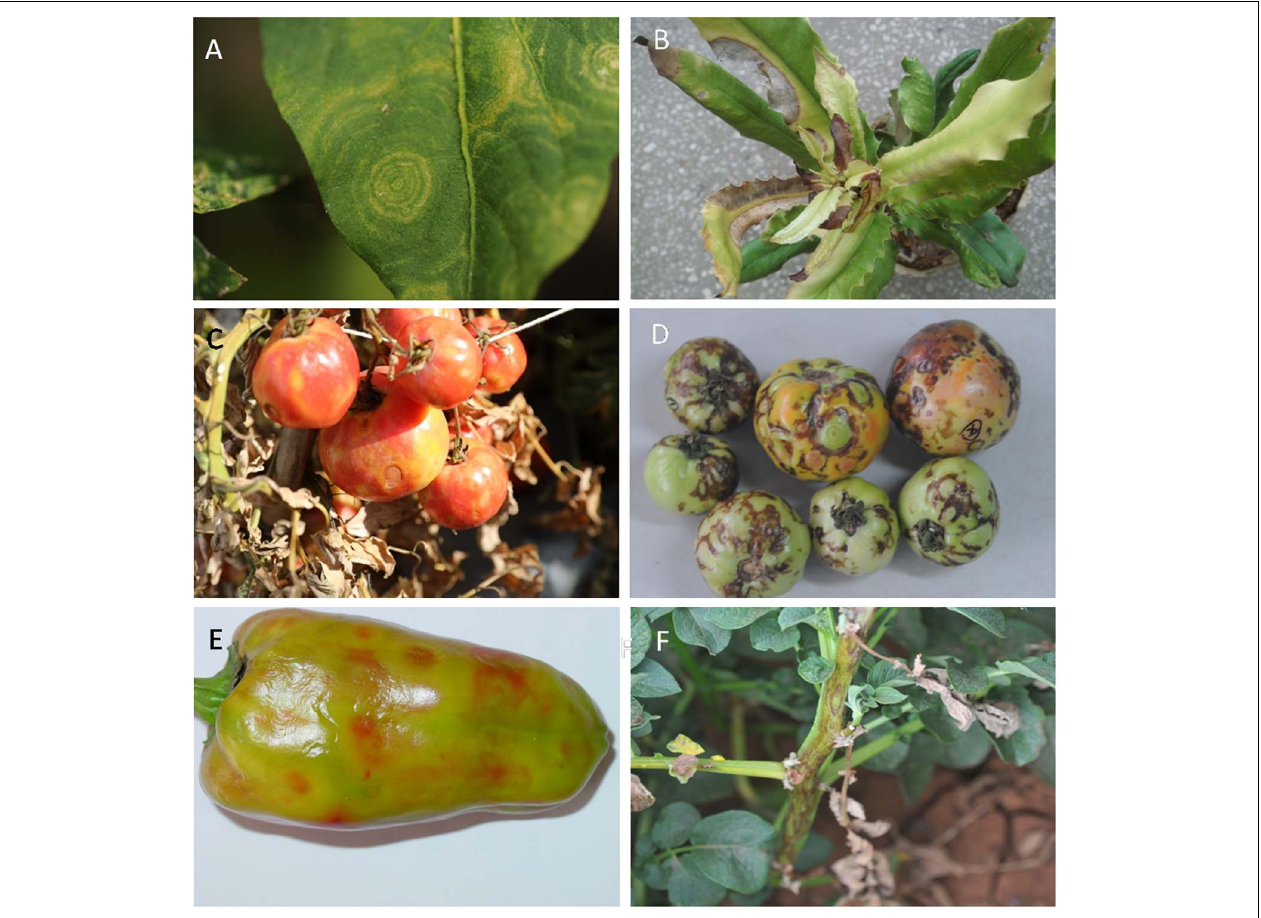
FIGURE 1 | Typical symptoms of host plants infected with orthotospoviruses under natural field conditions. (A) Zonate spot in leaf of chili pepper ( Capsicum annuum L.) infected with tomato zonate spot orthotospovirus (TZSV). (B) Necrotic spot in leaf of macadamia nut ( Macadamia ternifolia F. Muell.) infected with watermelon silver mottle virus (WSMoV) serogroup member. (C) Yellow spot and ringspot in tomato ( Solanum lycopersicum L.) infected with tomato spotted wilt orthotospovirus (TSWV). (D) Necrotic zonate spot in tomato infected with tomato necrotic spot-associated orthotospovirus (TNSaV). (E) Chlorotic spot in sweet pepper ( C. annuum L.) infected with TZSV. (F) Necrotic ringspot in potato ( Solanum tuberosum L.) infected with